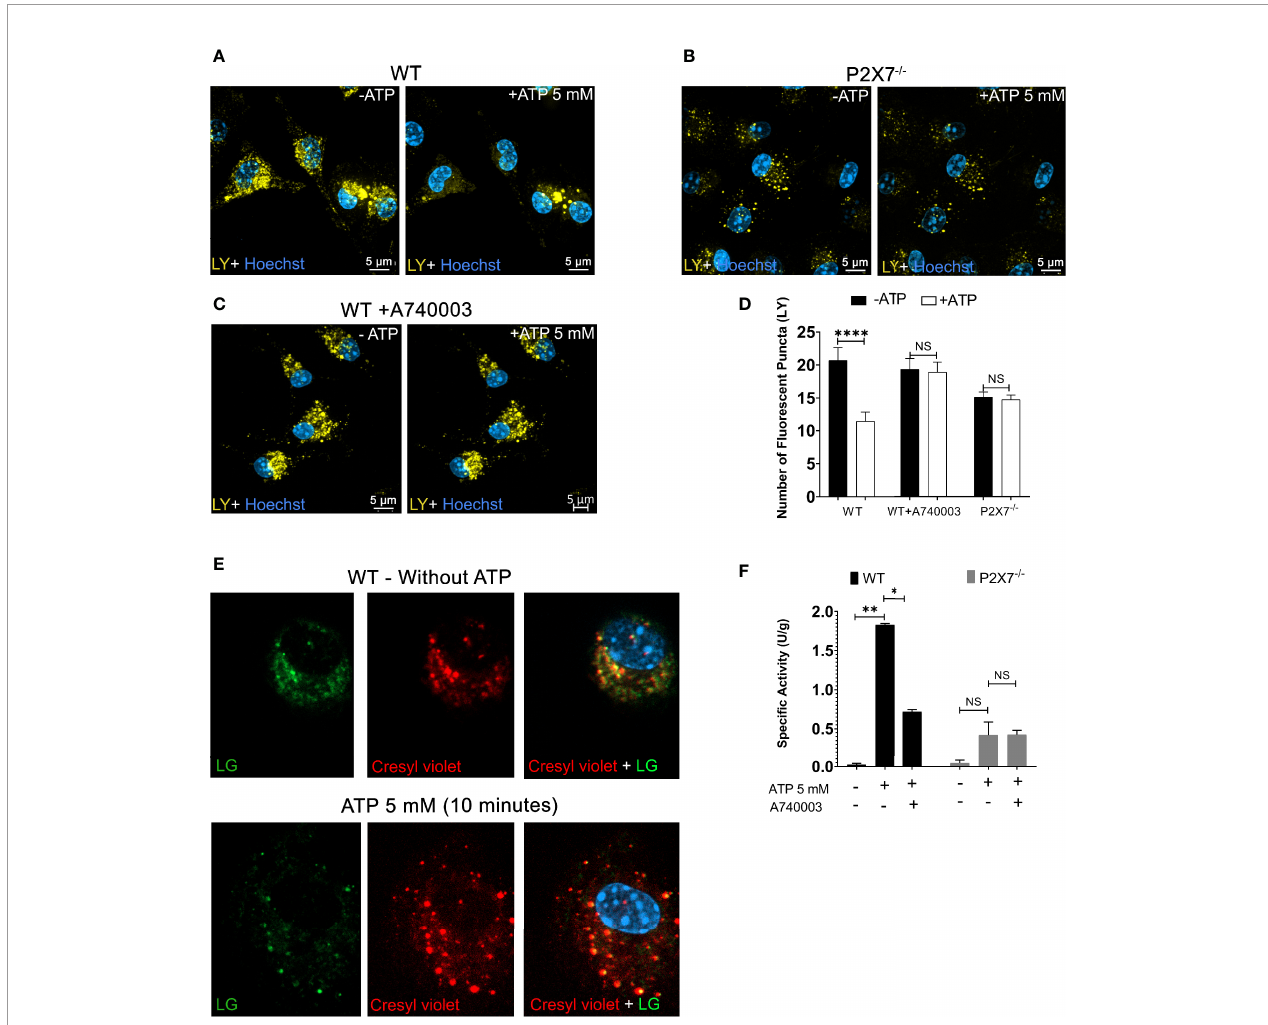
FIGURE 2 | P2X7 Receptor Activation Triggers Endolysosomal Rupture. (A) Representative images of peritoneal macrophages of WT preincubated with 1 mM of Lucifer Yellow (LY) for 45 min, (B) Peritoneal macrophages from P2X7 -/- mice; before and after treatment with 5 mM ATP for 10 minutes, and (C) WT macrophages pre-incubated with 100 nM A740003 for 30 minutes. (D) The number of fl uorescent puncta stained with Lucifer Yellow was counted before and after ATP treatment. (E) Representative images of peritoneal macrophages from WT mice incubated with the fl uorogenic substrate MR-RR2 given as product cresyl violet fl uorophore (red) for cathepsin B activity detection and Lysotracker Green (green) in the absence or presence of 5 mM ATP. (F) Cathepsin activity in the supernatants of cells pretreated with 100 nM A740003 and then treated with 5 mM ATP for 10 min. Scale bar, 5 µM; original magni fi cation 100x. Data are expressed as mean ± SEM of three independent experiments performed in triplicates. One-way analysis of variance *P < 0.05, **P < 0.001 and ****P < 0.0001. Analysis of conditions without ATP vs. after treatment with 5 mM ATP. NS, not signi fi